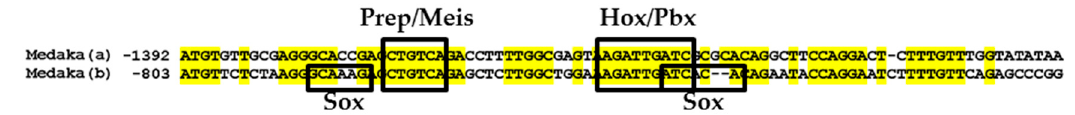
Figure 8. Sequence alignment of the medaka hoxa2a r4/CNCC and the ψ hoxa2b r3–7/CNCC specifying elements. The sequence corresponding to the medaka hoxa2a r4/CNCC specifying element is denoted by “a” in parentheses. The sequence corresponding to the medaka ψ hoxa2b r3–7/CNCC specifying element is denoted by “b” in parentheses. Numbers correspond to genomic base pair positions relative to the ATG start site of hoxa2a and ψ hoxa2b . Base pairs colored in yellow correspond to complete conservation at particular sites across both sequences examined. Black boxed regions correspond to transcription factor binding sites identified in this study.